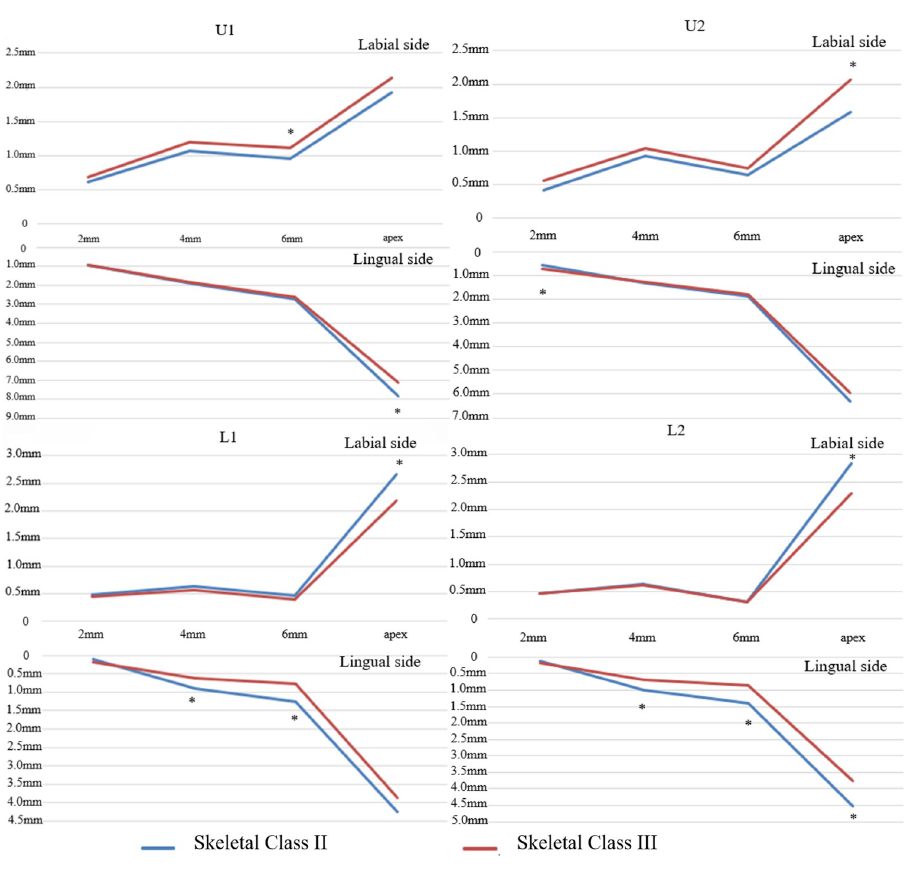
Fig 3. Comparison of the alveolar bone thickness of maxillary and mandibular anterior teeth between two groups. � P < 0.05.